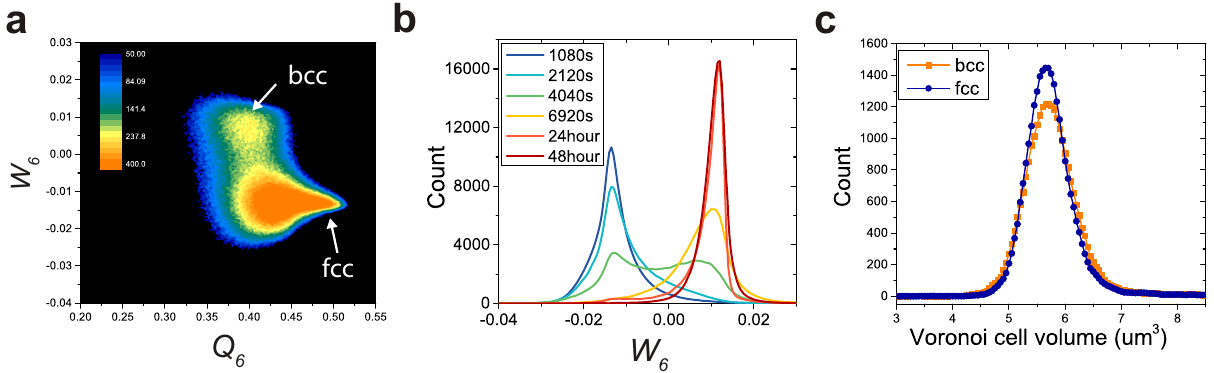
Fig. 2 Illustration of the fcc-to-bcc transition in the 2D order-parameter space. a 2D distribution of particles' local order in the Q 6 − W 6 parameter space for the strong-driving force (the data accumulated from t = 0 s to t = 8000 s). From the fcc-solid region of high Q 6 with negative W 6 , the particles undergo the decrease in Q 6 and the increase in W 6 on the 2D parameter space and eventually transform to bcc solid with a jump of W 6 . We can see that liquid particles ( Q 6 < 0.35) rarely participate in the transformation process. b The W 6 distribution of particles at different time. It suggests the effectiveness of W 6 to distinguish fcc from bcc. c The Voronoi cell volume, which is inversely proportional to the local density, for fcc particles (the parent phase) and bcc particles (the product phase). We can see a tiny density difference (0.68%) between the two phases.